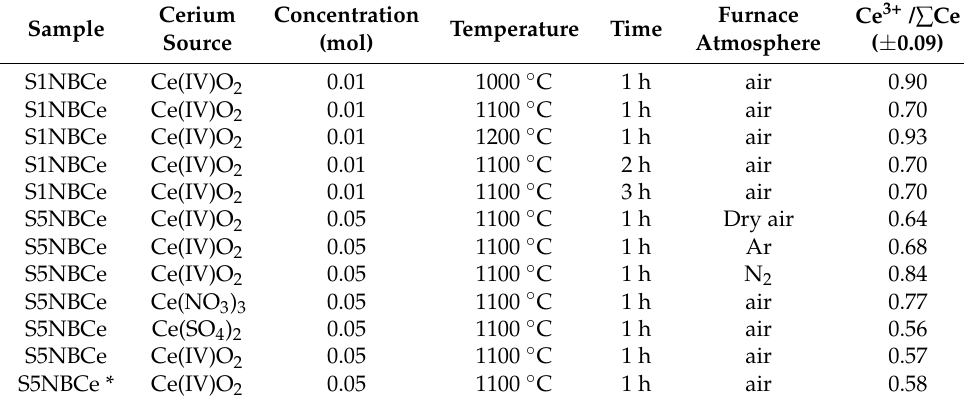
Table 4. The concentrations of Ce 3+ and Ce 3+ /Ce 4+ ratio within the processed glasses Na 2 O · 2B 2 O 3 melted with different melting